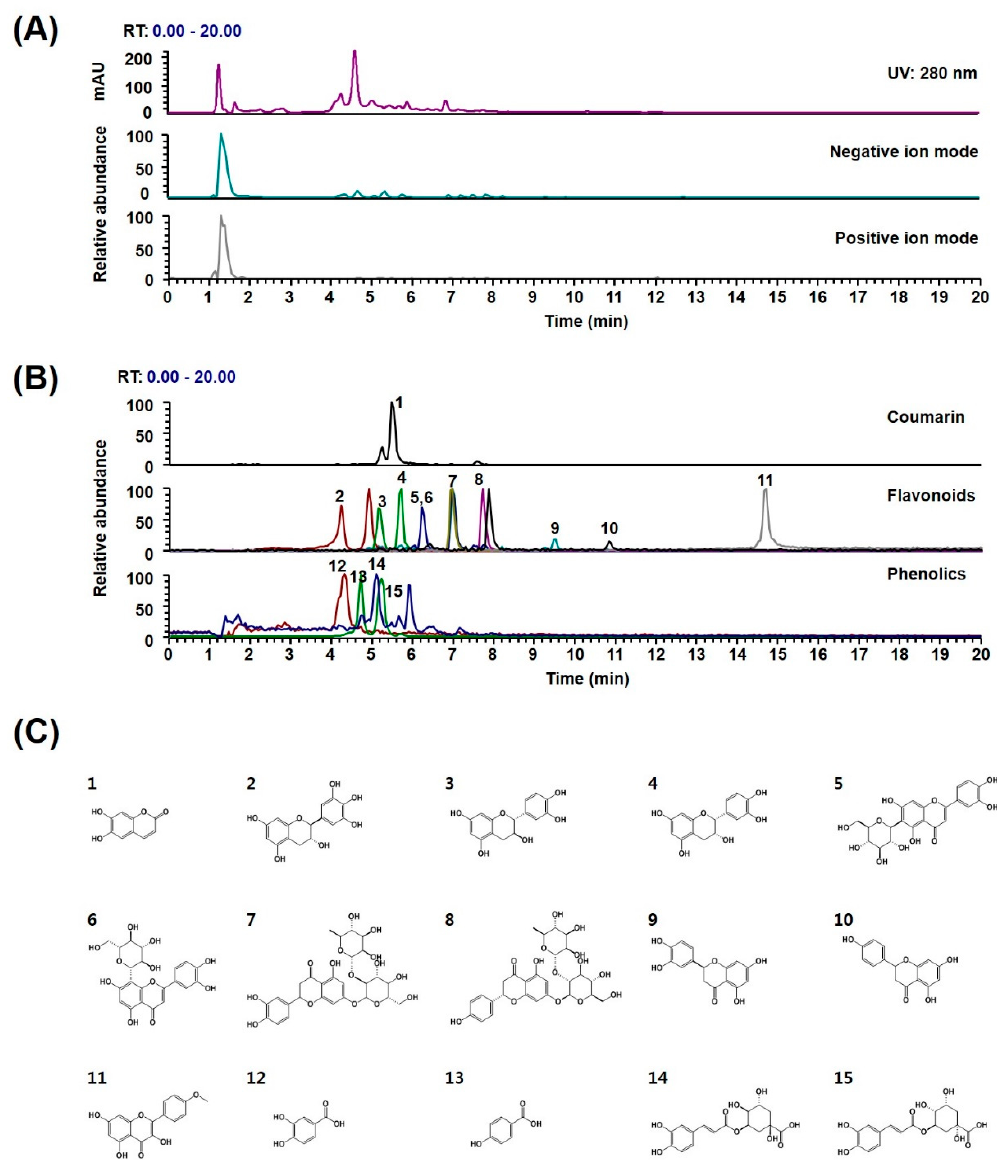
Figure 4. UHPLC–MS/MS analysis of WDR. ( A ) UV and base peak chromatograms of WDR. ( B ) Extracted ion chromatogram of the 15 identified chemical constituents. ( C ) Chemical structures of the constituents. RT, retention time. The peak numbers correspond to the compounds mentioned in ( C ) and Table 1.